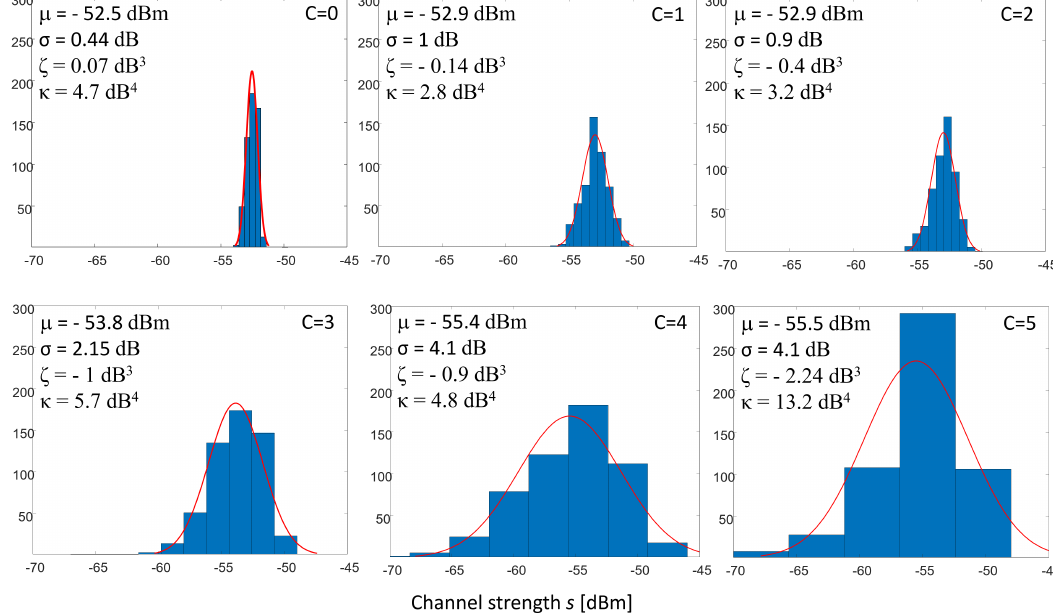
Figure 2. Histogram p f , (cid:96) ( s ) of the CSI strength sample s 5,5 in dBm, for f = f 5 and (cid:96) = 5, and the corresponding extracted features including mean [dBm], standard deviation [dB], skewness [dB 3 ], and kurtosis [dB 4 ] over time series. Measurements are obtained from the proposed system deployed in the layout shown in Figure 3 in the empty space case ( C = 0) and for the subject number C ranging from 1 up to